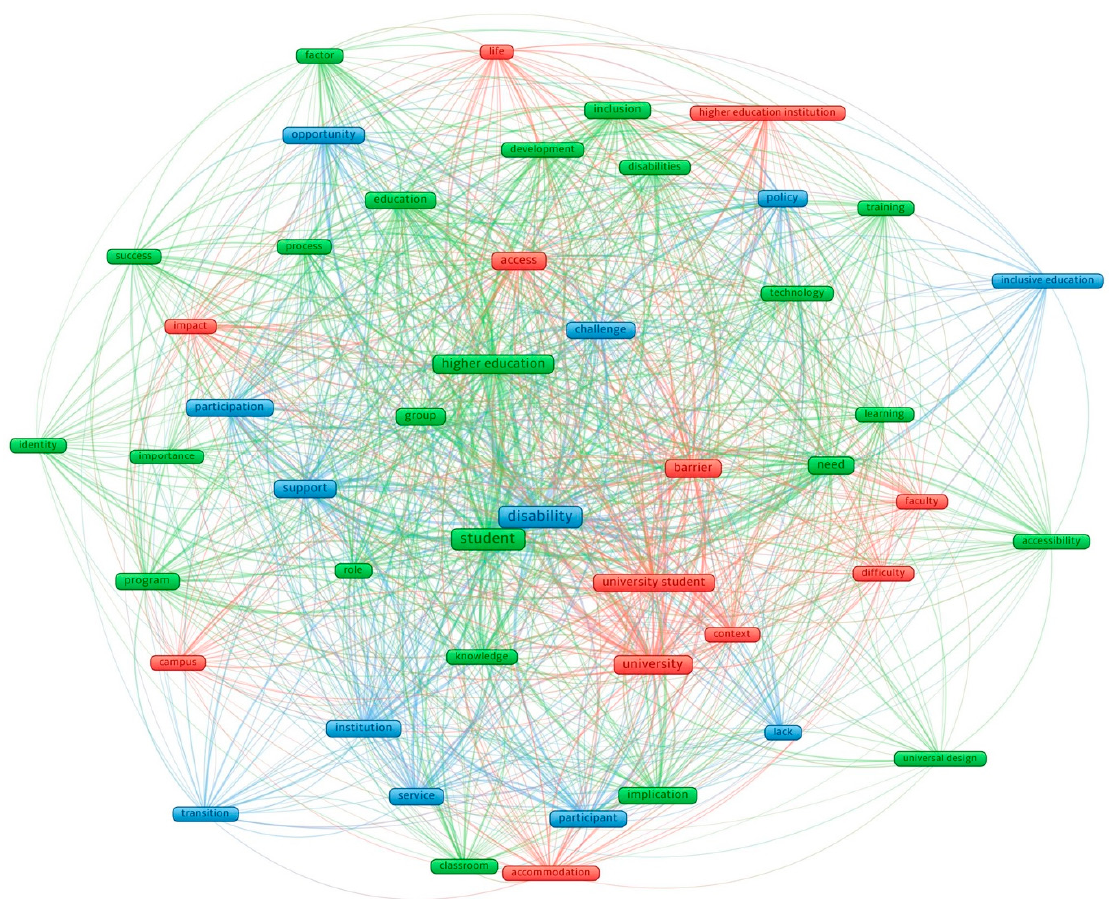
Figure 5. Network of extracted keywords.